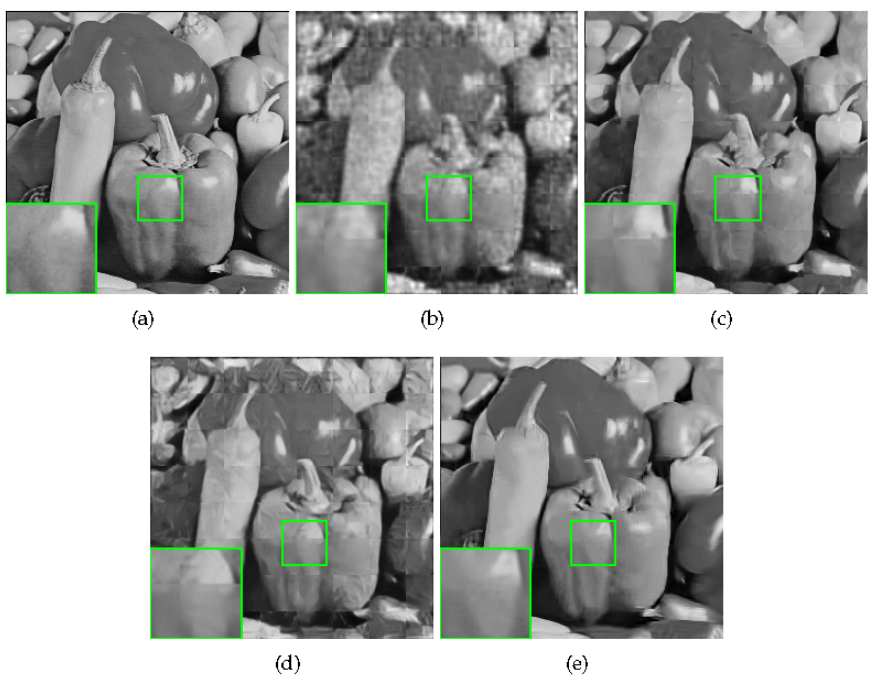
Figure 8. Reconstruction of Monarch with sampling rate = 0.1. ( a ) Original image; ( b ) ReconNet (PSNR = 22.14 dB, FSIM = 0.7840); ( c ) ISTA-Net + (PSNR = 27.23 dB, FSIM = 0.8862); ( d ) DR 2 -Net (PSNR = 23.73 dB, FSIM = 0.8282); ( e ) Proposed HNLSR (PSNR = 27.91 dB, FSIM = 0.8962 ).